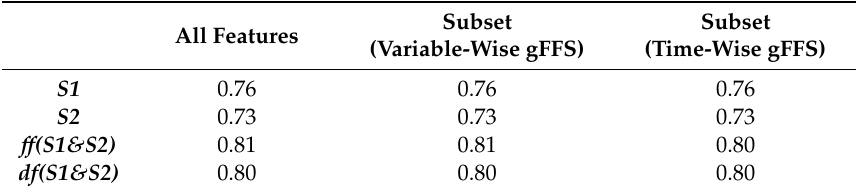
Table 2. Classification accuracies (f1-score) based on all features and the features subsets selected based on time-wise and variable-wise gFFS after grouping legume and cereal classes. Subset All Features